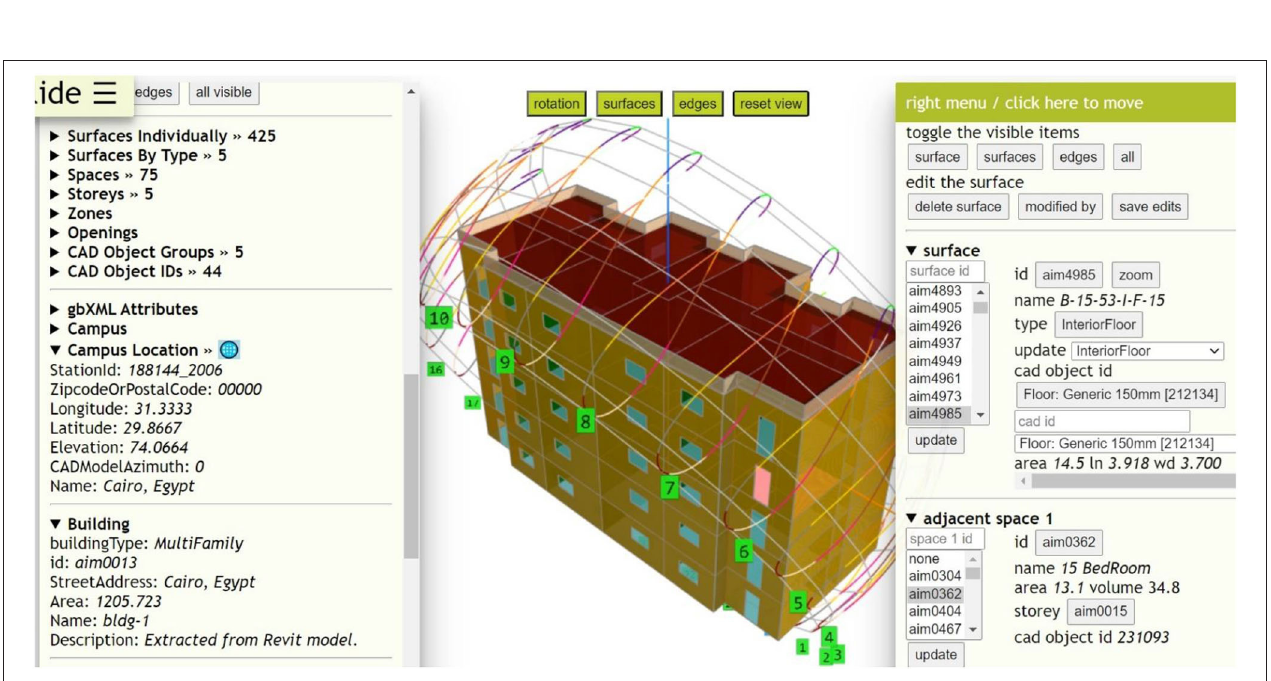
FIGURE 8 | DesignBuilder notification, including the number of buildings, blocks, and zones identified after the transfer.